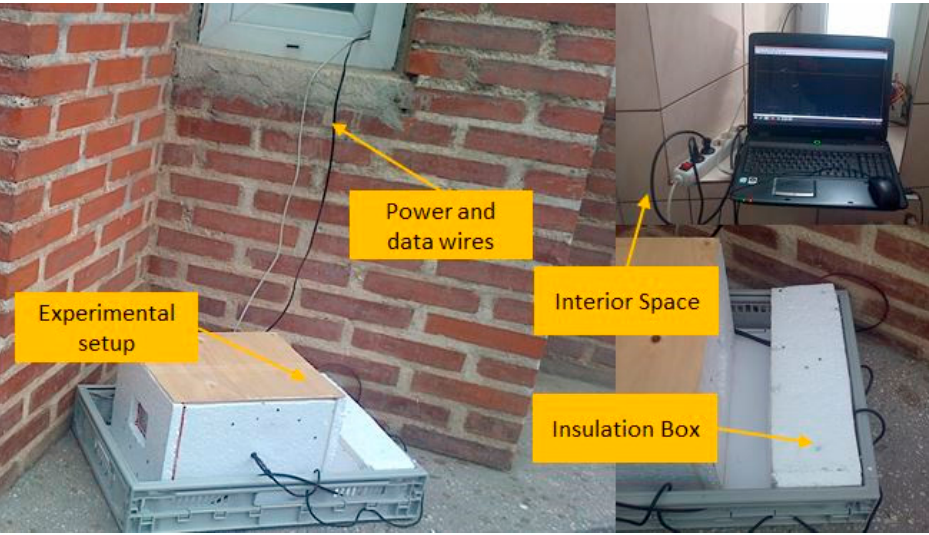
Figure 15. The experimental setup employed in the exterior environment.